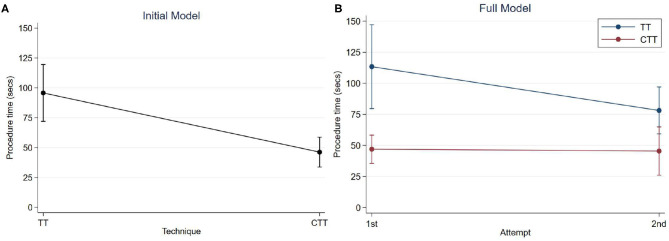
Predicted mean procedure time with 95% confidence intervals; (A) Initial model, by technique; (B) Full model, by technique and attempt.